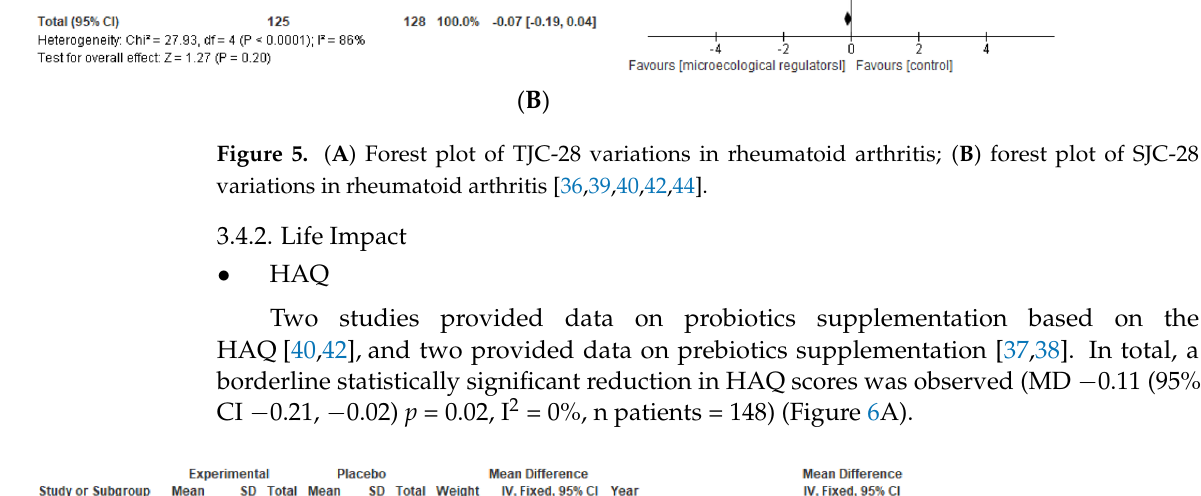
Figure 5. ( A ) Forest plot of TJC-28 variations in rheumatoid arthritis; ( B ) forest plot of SJC-28 varia- tions in rheumatoid arthritis [36,39,40,42,44].